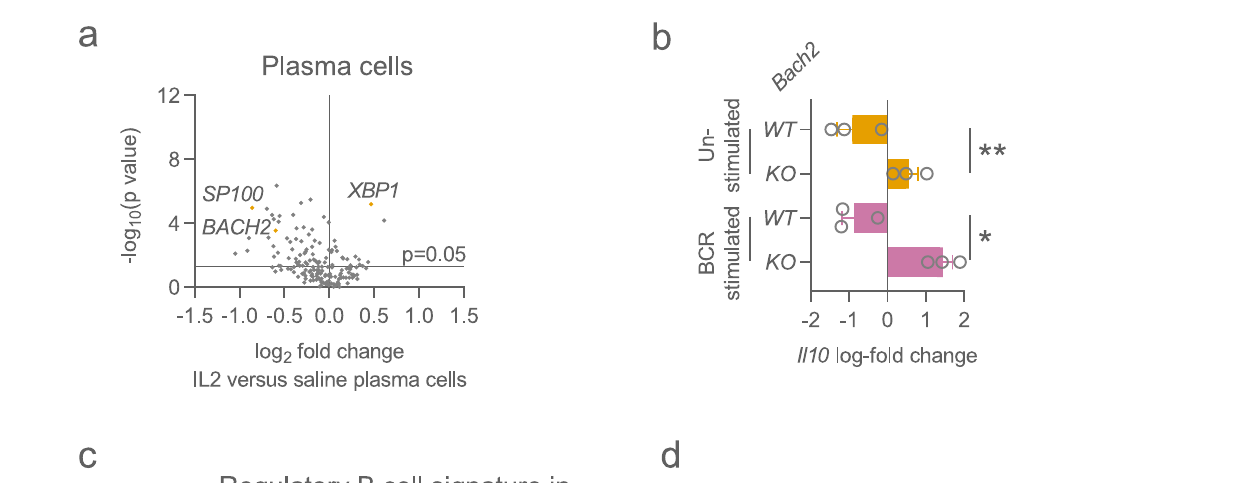
Fig. 3 |In-depth analysisofB cellsand plasmacells frompatientsgivenLDIL-2 treatment. a Diagrammatic schema summarising the three treatment groups of the trial. Patients received either saline, or 1.5×10 6 IU, or 2.5×10 6 IU IL-2. b Proportion of IL-10-positive B cells in patients prior to and following the administration saline (left) or 1.5×10 6 IU IL-2 (right). n =4 and 6 analysed by fl ow cytometryofuntreatedandtreatedgroupsrespectively. p -valuesgeneratedusinga paired two-tailed parametric t-test. * p <0.05. c Representative fl ow cytometryplot ofIL-10expressingBcellspre-andpost-LDIL-2. d Uniformmanifoldapproximation andprojectionoffourclustersofallBandplasmacellsfromallsamplesanalysedby